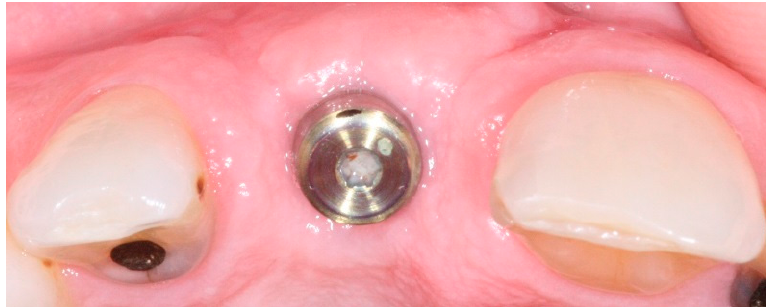
Figure 1. Healing abutment in place after three months of surgical implant placement.